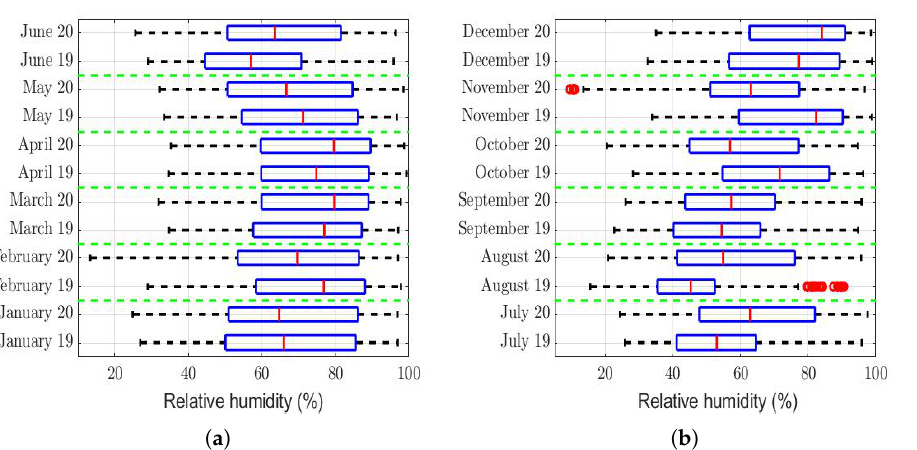
Figure 5. Box plot of the relative humidity (%): 2019 vs. 2020. The red circles represent the outliers.